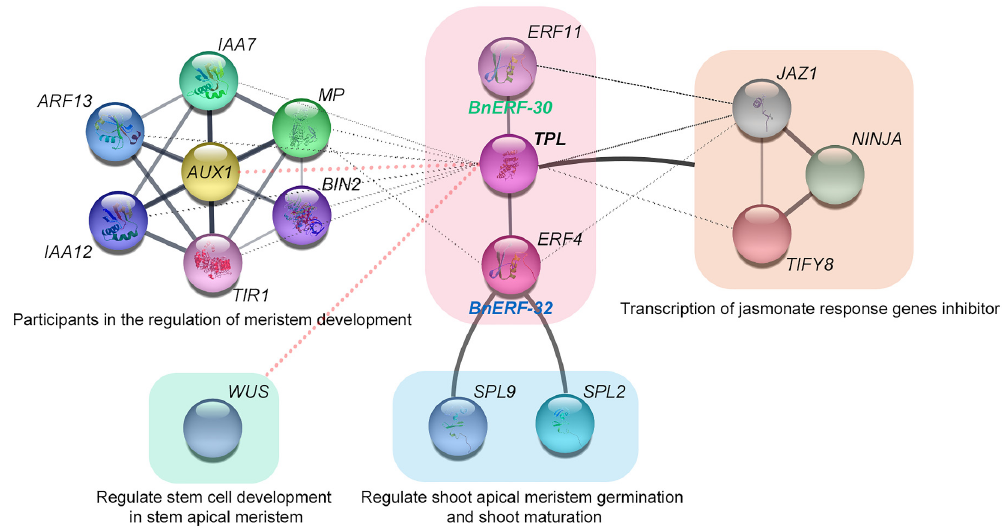
Figure 11. A BnAP2/ERF protein interaction network based on Arabidopsis homologs.